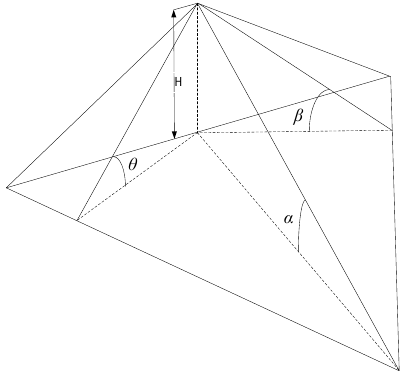
Figure 2. Three -dimensional model of the ridge slope.